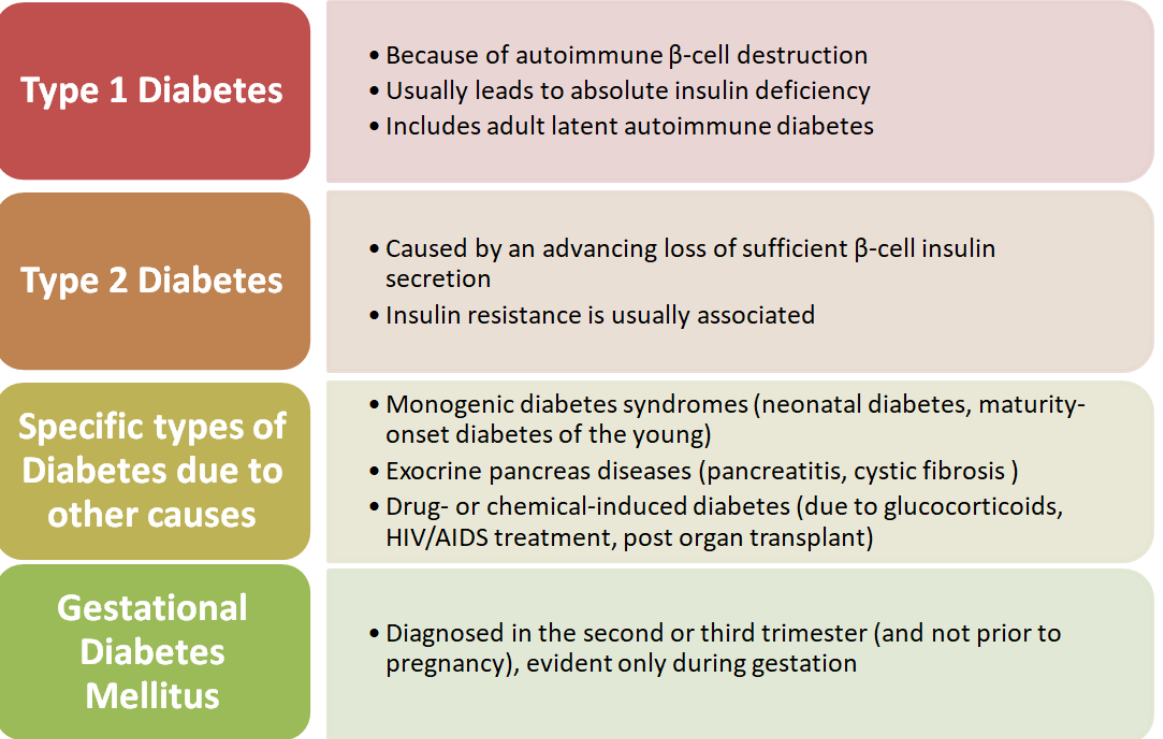
Figure 1. Schematic representation of the classification of diabetes.